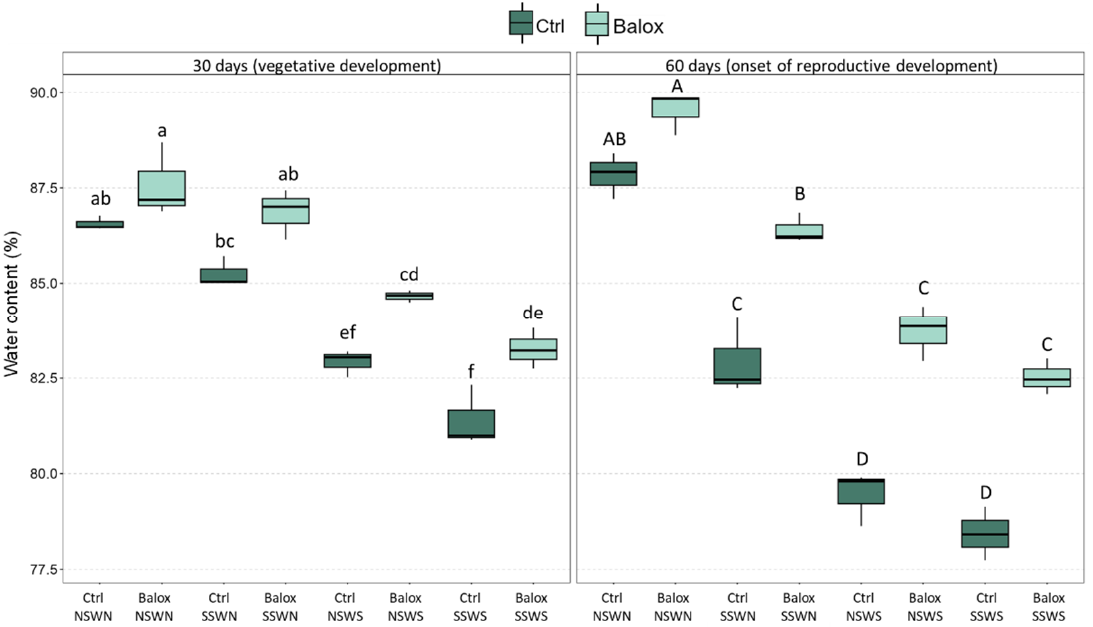
Figure 3. Total water content in tomato plants subjected to increasing salinity by different combi- nations of saline or non-saline soil and irrigation water; the plants were treated, or not, with the biostimulant containing polyphenols at 1.4% ( w / w ) and glycine betaine at 3.0% ( w / w ) at a dose of 0.4 mL L − 1 of irrigation water. The control treatments without biostimulant (Ctrl) and with biostimulant (BALOX ® ) are defined as follows: (i) NSWN: Non-saline soil (EC = 2.28 dS/m) and non-saline water (EC = 0.91 dS/m); (ii) SSWN: Saline soil (EC = 8.55 dS/m) and non-saline water (EC = 0.91 dS/m); (iii) NSWS: Non-saline soil (EC = 2.28 dS/m) and saline water (EC = 10.50 dS/m); (iv) SSWS: Saline soil (EC = 8.55 dS/m) and saline water (EC = 10.50 dS/m). The evaluation periods: 30 days and 60 days of treatments. The values are the means ± SE ( n = 3). Different letters above the bars (lowercase for 30 days and capital for 60 days treatments) indicate significant differences between treatments, ac- cording to the ANOVA test ( p < 0.05). Statistical analyses were performed independently for the two treatment periods.